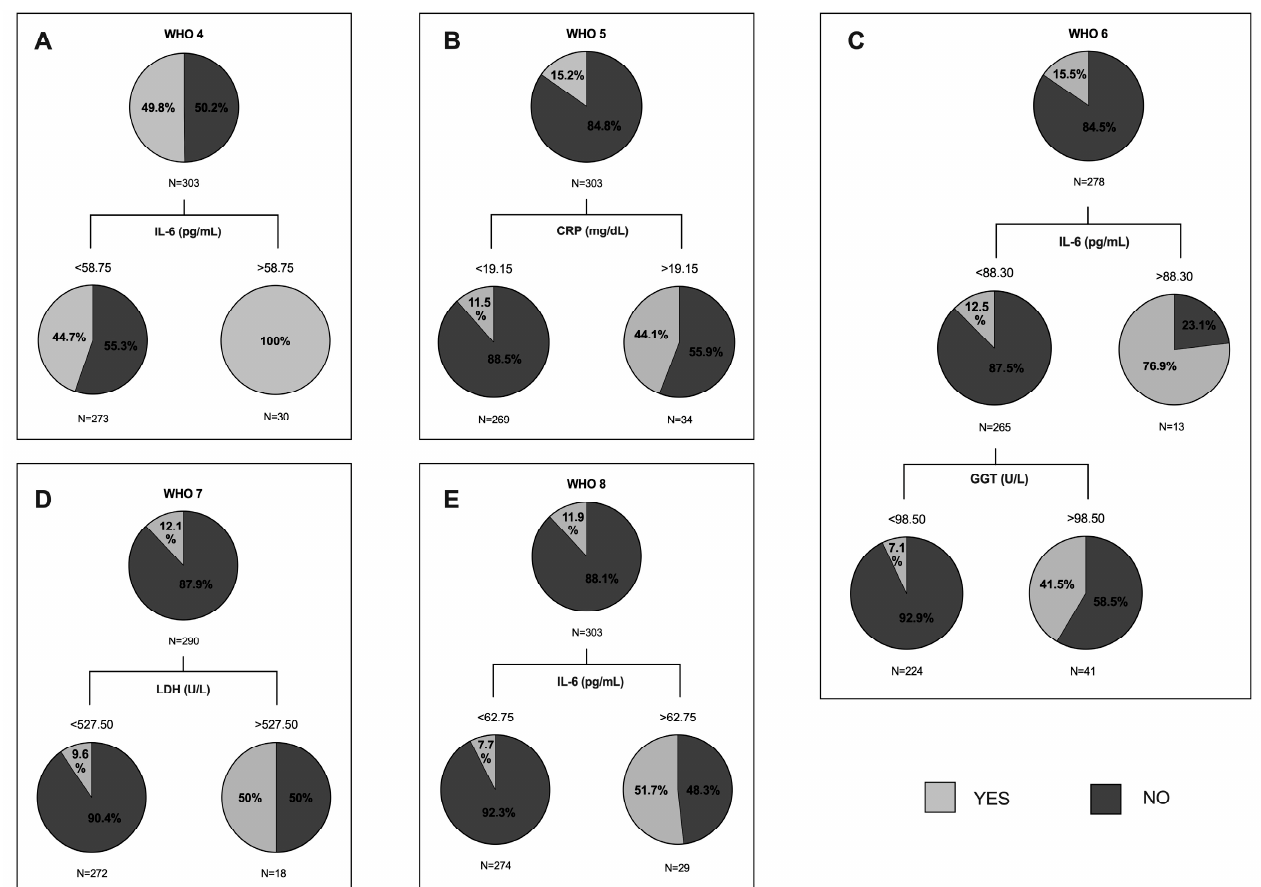
Figure 1. Classification and regression trees of the whole cohort of study were elaborated through CRT method for World Health Organization (WHO) eight-point classification of severe pneumonia by COVID-19 (namely: (0) no clinical or virological evidence of covid-19 infection; (1) infected without limitations; (2) limitation of activity; (3) hospitalized without oxygen therapy; (4) oxygen by mask or nasal; (5) non-invasive ventilation (NIV) (continuous positive airway pressure (CPAP) or positive bipressure in the airways (BiPAP)) or high-flow oxygen (HFO); (6) intubation with mechanical ventilation (MV) or mask with reservoir; (7) MV or extracorporeal membrane oxygenation (ECMO), support with vasopressors, dialysis/renal replacement therapy; and (8) death. ( A ) Pie charts represent the proportion of patients who met the WHO 4 (light grey) or not (dark grey) at each node of the tree. IL-6: interleukin 6. ( B ) Pie charts represent the proportion of patients who met the WHO 5. CRP: c-reactive protein. ( C ) Pie charts represent the proportion of patients who met the WHO 6. IL-6: interleukin 6; GGT: gamma-glutamyl transferase. ( D ) Pie charts represent the proportion of patients who met the WHO 7. LDH: lactate dehydrogenase. ( E ) Pie charts represent the proportion of patients who met the WHO 8. IL-6: interleukin